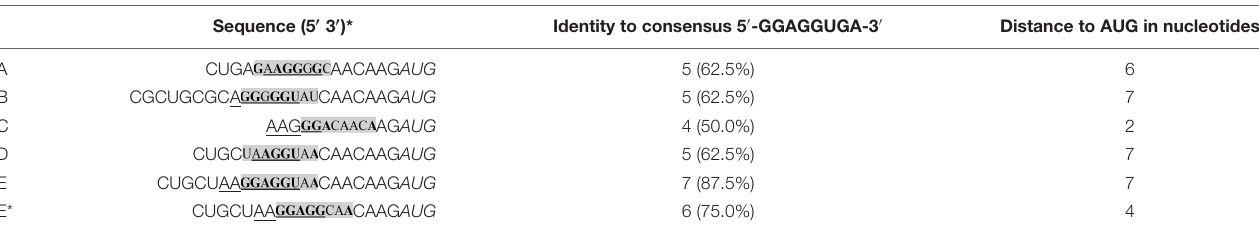
*Putative haloarchaeal SD sequences shaded in gray; the bacterial SD sequence is underlined. Nucleotides identical to the consensus sequence are in bold. The AUG start codon is in italics.